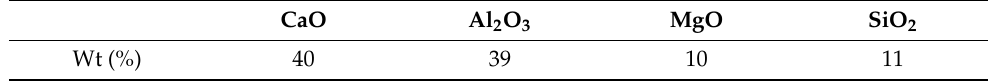
Table 2. Chemical compositions of the refining slag